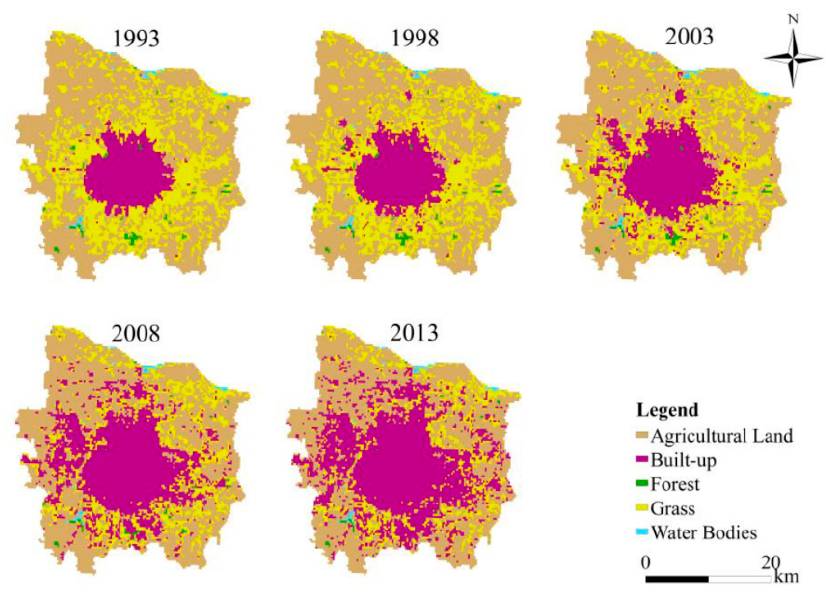
Figure 4. Land use classification of Zhengzhou. Table 2. Areas of different land use patterns in Zhengzhou from 1993 to 2013 (km 2 ). Land